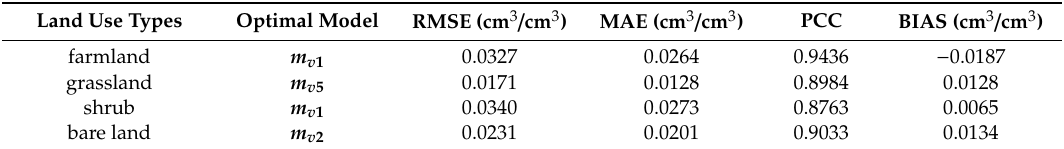
Table 6. Optimal solution strategy based on land use types and the accuracy of each algorithm (strategy